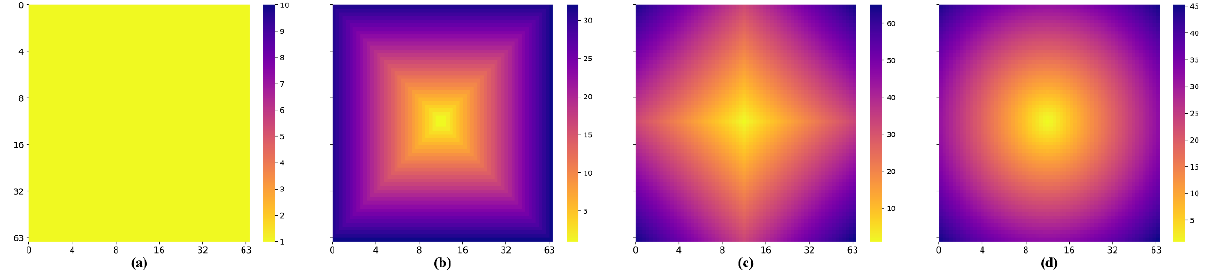
Figure 4. The heat map of the weights used by the AAW method, and the distances obtained by using different distance functions in the 33rd slice of a 64 × 64 × 64 voxels patch. ( a ) AAW method; ( b ) Chebyshev distance; ( c ) Manhattan distance; ( d ) Euclidean distance.